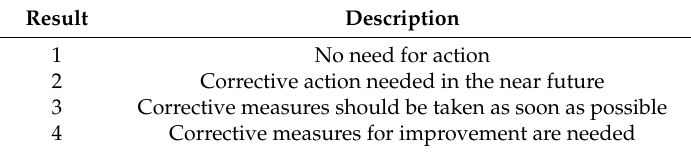
Table 3. Interpretation of results for the Ovako Working Posture Analysis System (OWAS)